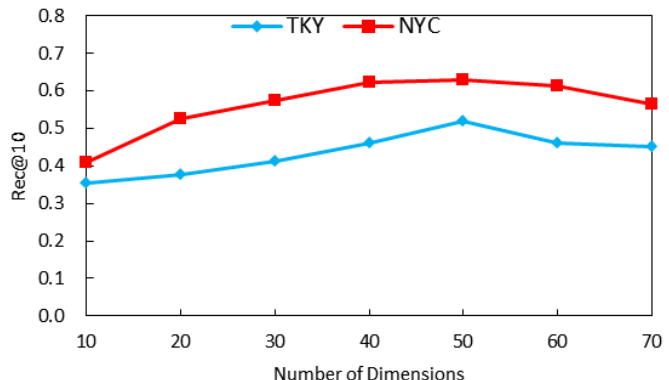
Figure 5. Effect of embedding size in Rec